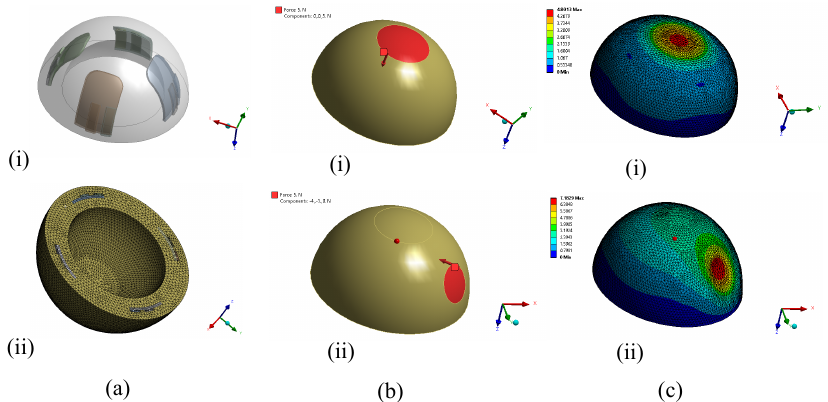
Figure 9. Simulation steps to evaluate the sensor shell deformation: ( a ) (i) geometry of the sensor and (ii) mesh; ( b ) direction of the applied forces: force parallel to (i) z-axis and (ii) xy-plane; ( c ) total deformation contour as the result of applied force along (i) z-axis and parallel to (ii) xy-plane.